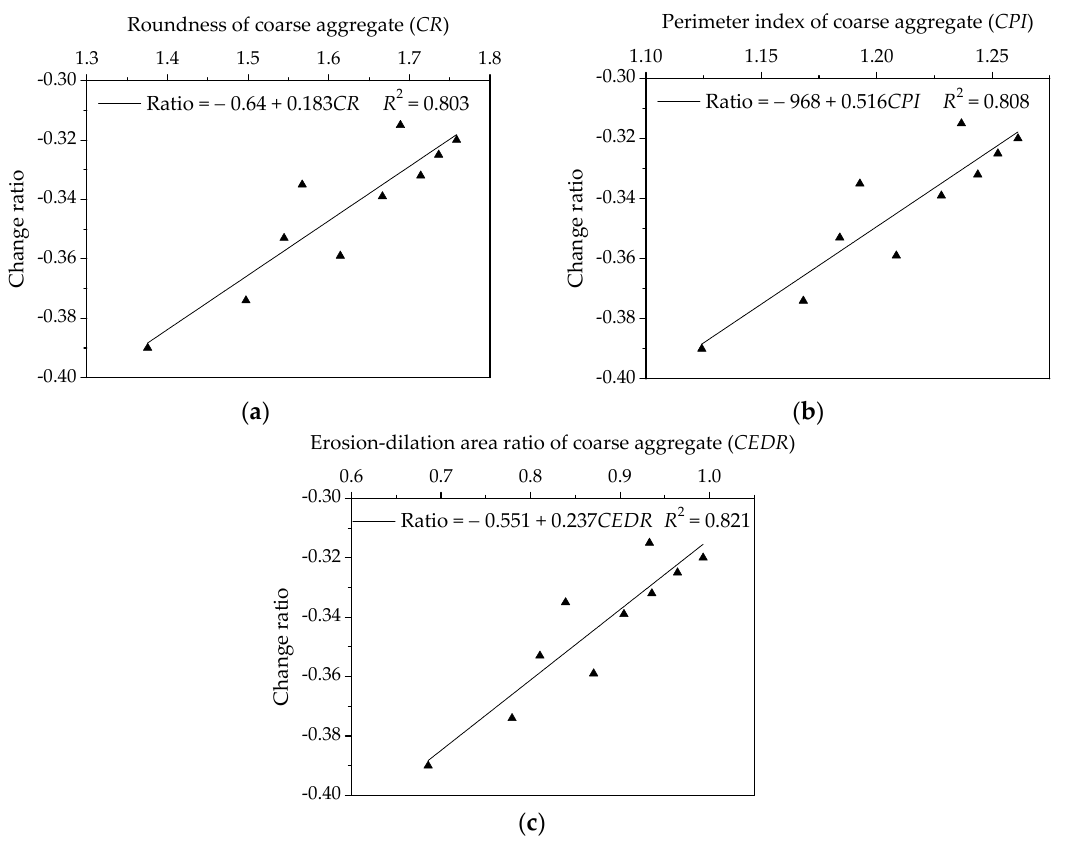
Figure 21. Influences of coarse aggregate morphological characteristics of on change rate of relaxation modulus for asphalt mixtures: ( a ) Shape ( CR ); ( b ) Angularity ( CPI ); and, ( c ) Texture ( CEDR ).